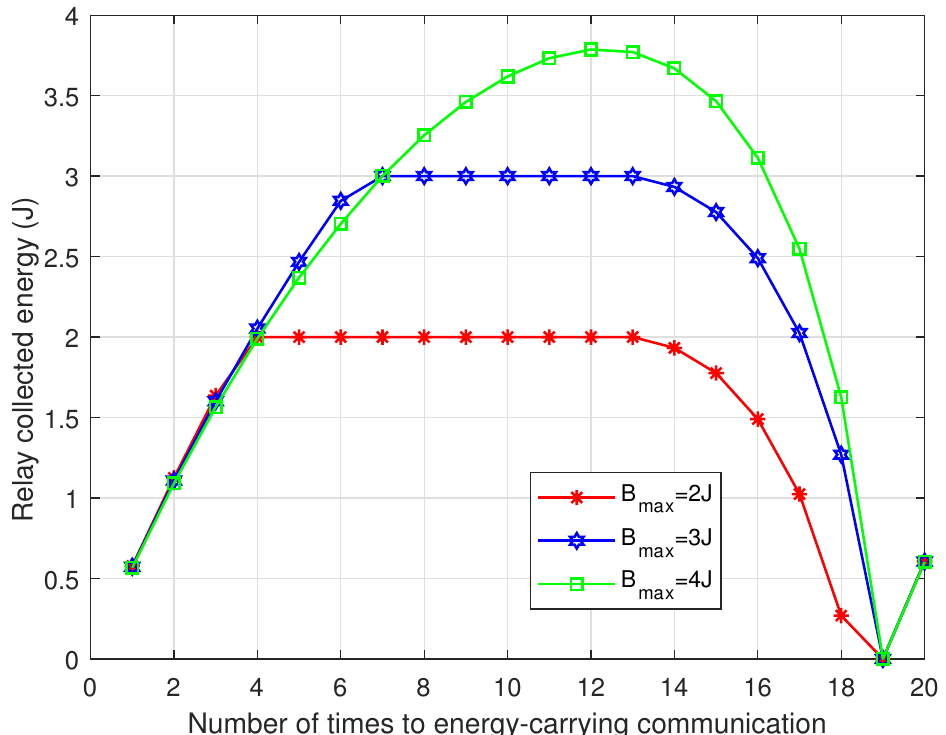
Figure 7. Relay collected energy at different energy